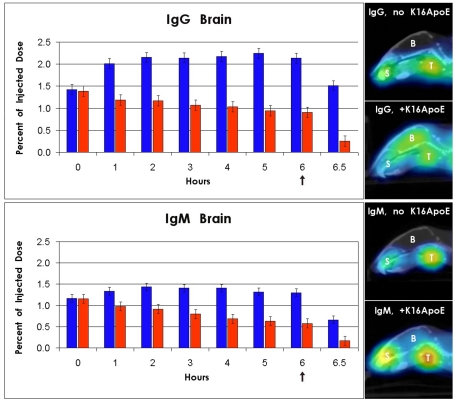
Evaluation of K16ApoE-mediated delivery of IgG (A) and IgM (B) in brain by microSPECT.Imaging was done at 1 h interval up to six hours, after which cardiac perfusion was performed, and final imaging carried out 30 min after perfusion. Blue bars – delivery with K16ApoE; red bars – delivery without K16ApoE. The upward arrows at time 6 h indicate time when cardiac perfusion was performed. Right panel – microSPECT images of mice head after perfusion after delivery of radiolabeled IgG and IgM. B – brain; S – salivary gland; T – thyroid.